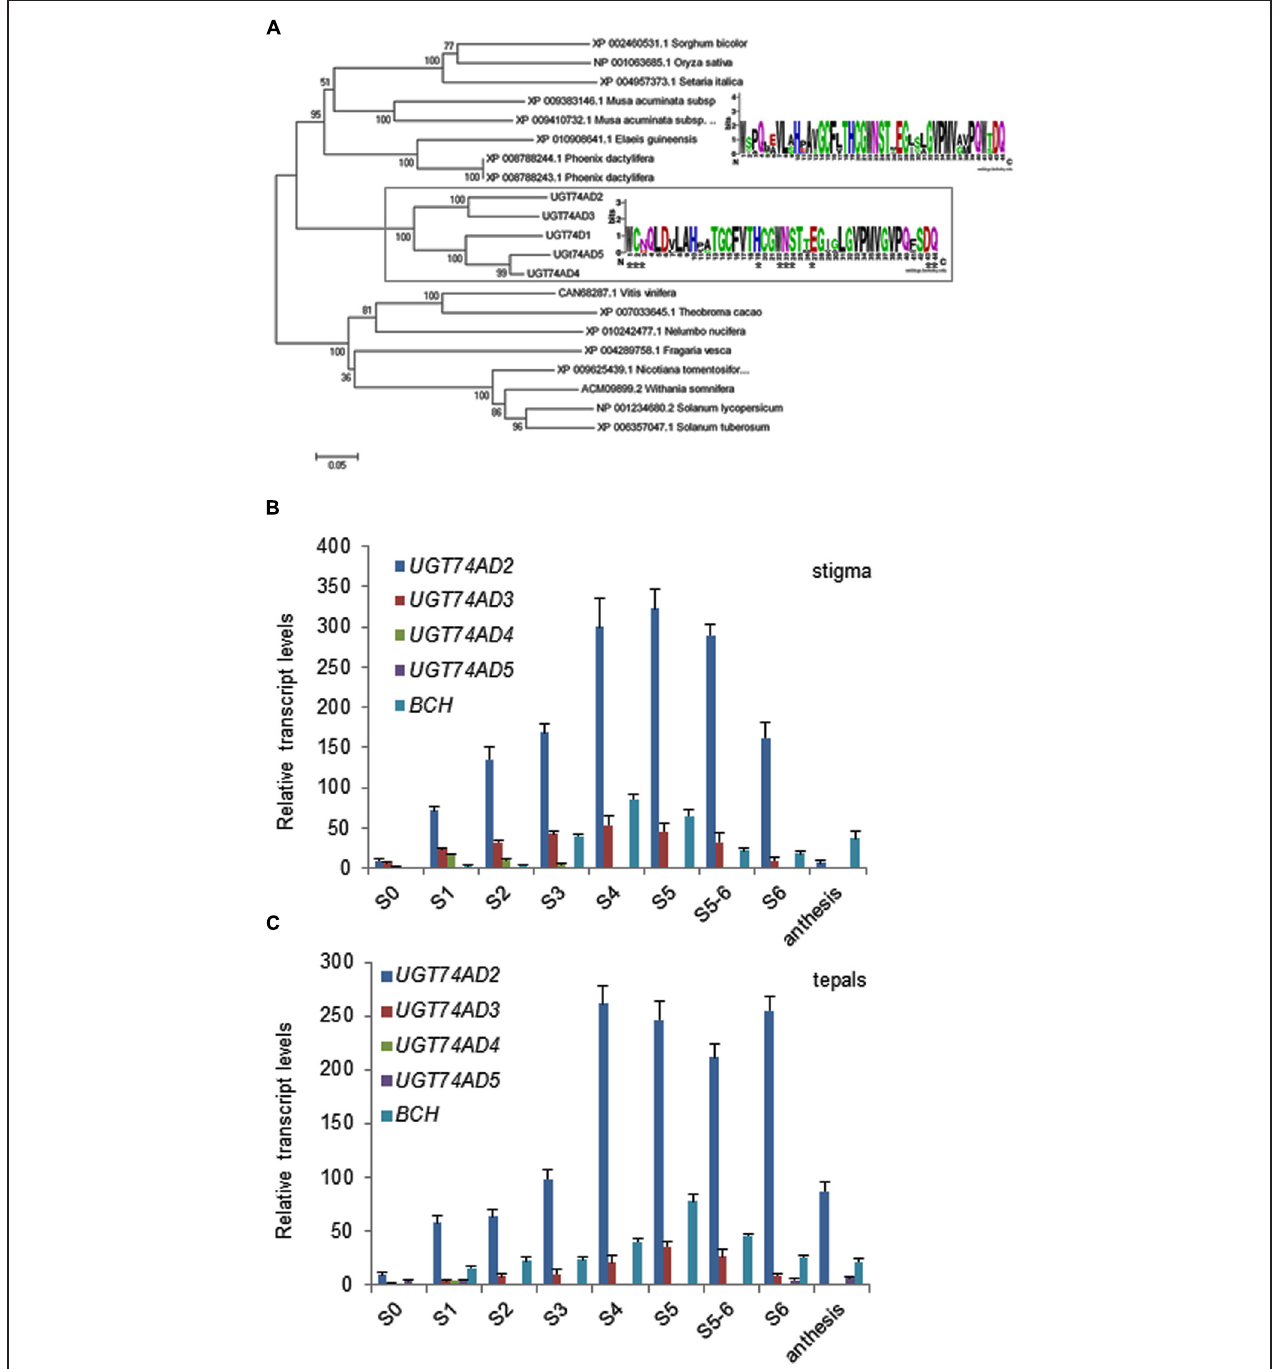
FIGURE 6 | Analysis of UGT74AD sequences identified in C. ancyrensis flowers. (A) Phylogenetic analysis of UGT74AD proteins. An un-rooted phylogenetic tree was constructed with the neighbor-joining method based on ClustalW multiple alignments. The percentages of replicate trees in which the associated taxa clustered together in the bootstrap test are shown next to the branches. The sequences isolated in this study are framed with UGT74AD1, from C. sativus . Inside the frame, the consensus PSPG box from these proteins is shown. The PSPG consensus box for those UGTs more closely related and present as a sister cluster is shown above. (B) Expression analysis of UGT74AD2 , UGT74AD3 , UGT74AD4 , and UGT74AD5 in the stigma during its development. (C) Expression analysis of UGT74AD2 , UGT74AD3 , UGT74AD4 , and UGT74AD5 during the development of tepals. The relative expression levels of BCH were incorporated for comparison. Values are means of three technical replicates ± SE, normalized to the internal control